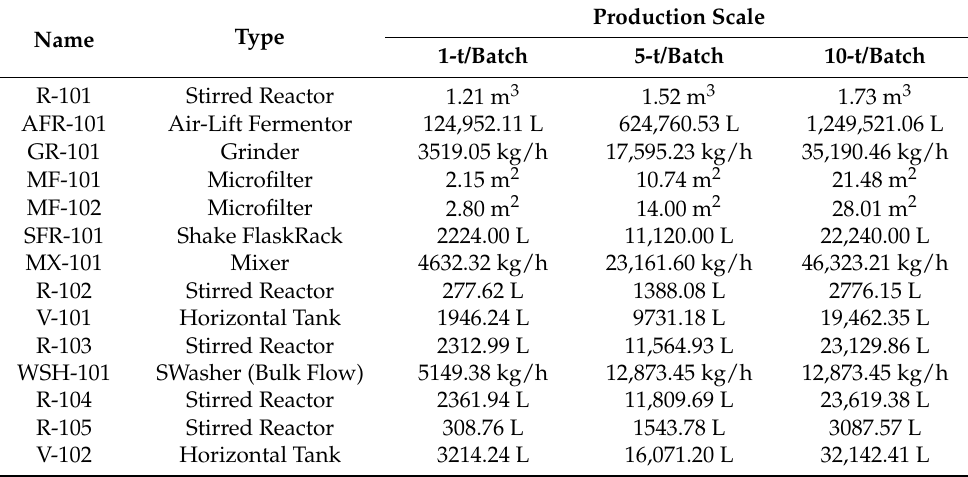
Table A3. Equipment types and size for Ti powder plant for different production scale of Ti powder.